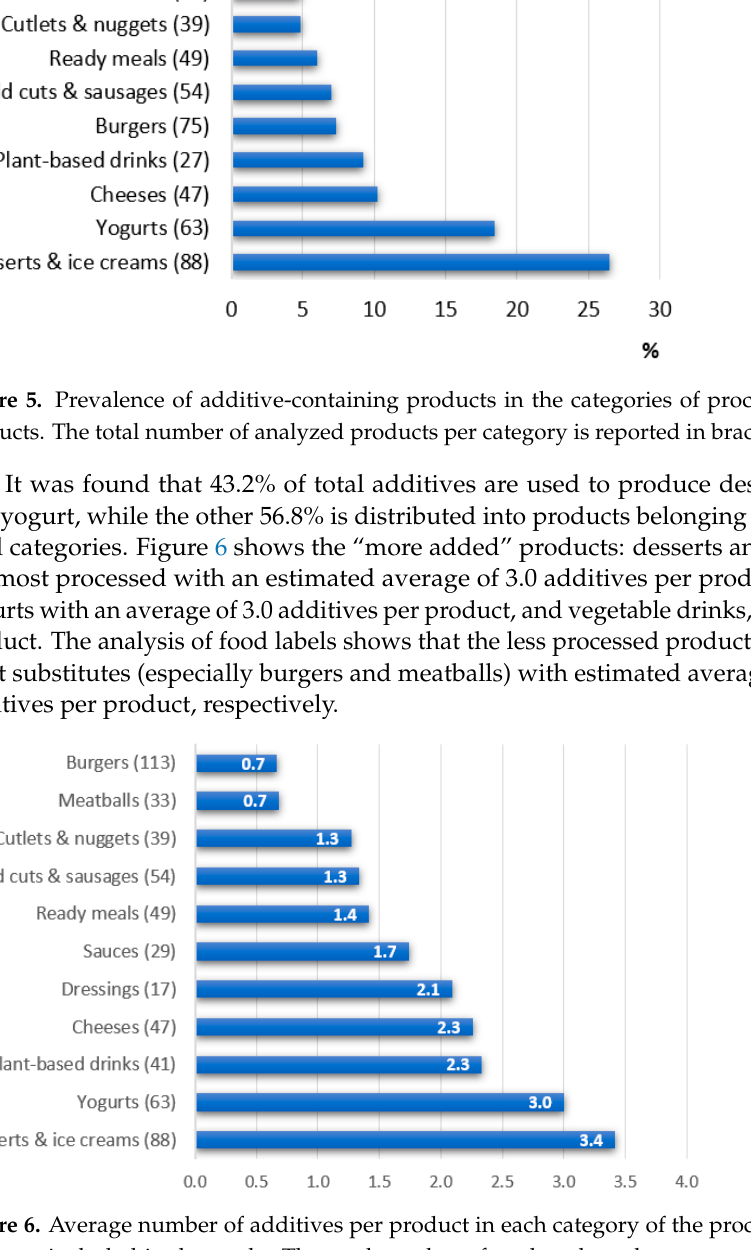
Figure 6. Average number of additives per product in each category of the processed plant-based products included in the study. The total number of analyzed products per category is reported in brackets.